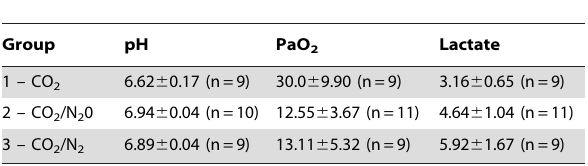
Table 1. Values of pH, P a O 2 (mmHg) and lactate (mmol.l 2 1 ) measured in arterial blood at the time of loss of righting